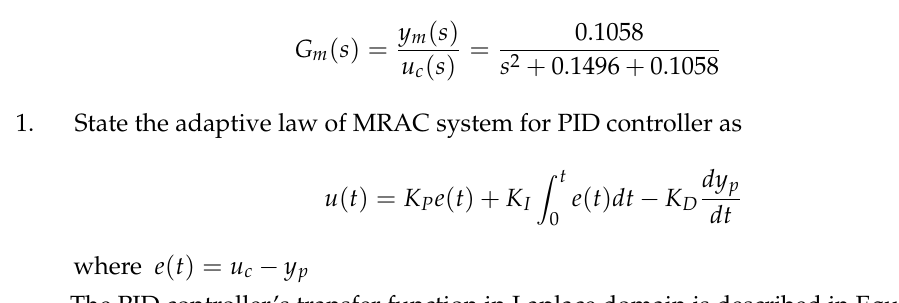
Figure 11. MRAC Adaptive PID Controller with MIT for an X3D Quadrotor.